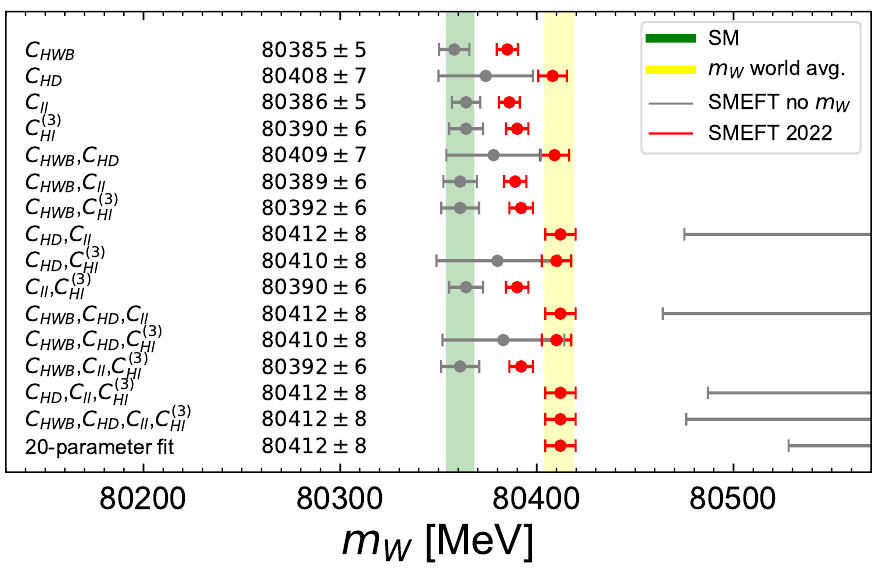
Figure 4 . Values of m W in fits including all combinations of operators entering linearly in m W , including from 1 to 4 operator coefficients, as well as a fit to 20 operator coefficients. Results omitting direct measurements of m W are shown in grey, and results using the current world average of m W measurements including that by CDF are shown in red. The vertical green band is the SM prediction for m W based on other data, and the yellow band is the current world average of m W